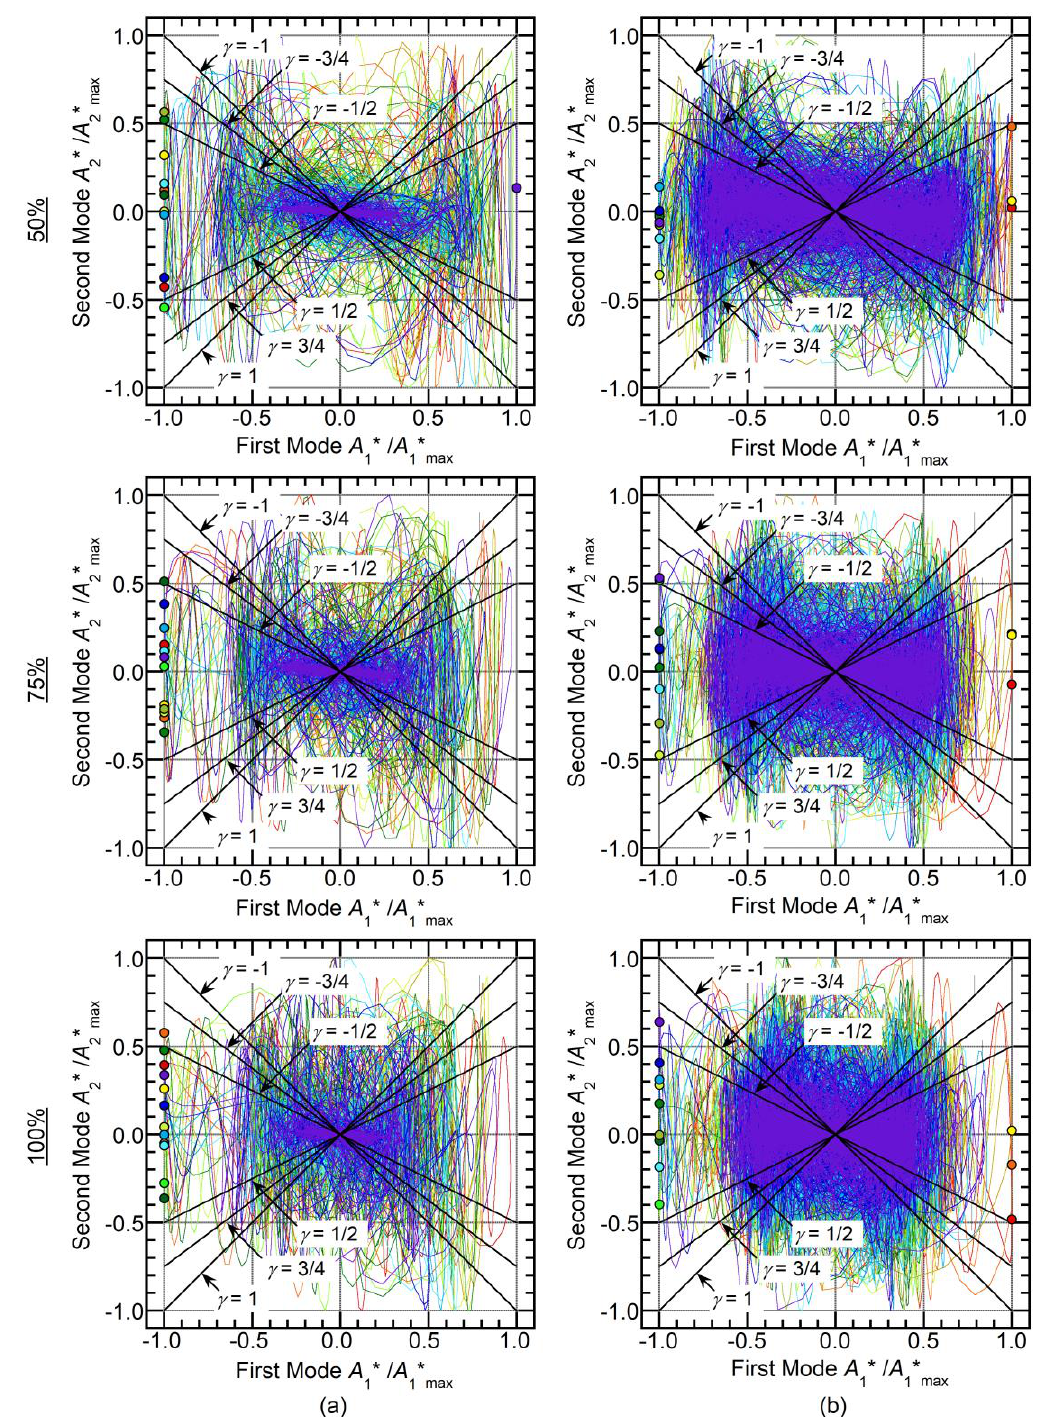
Figure 13. Orbit of normalized equivalent acceleration (Model-05): ( a ) Art-S series and ( b ) Art-L series.